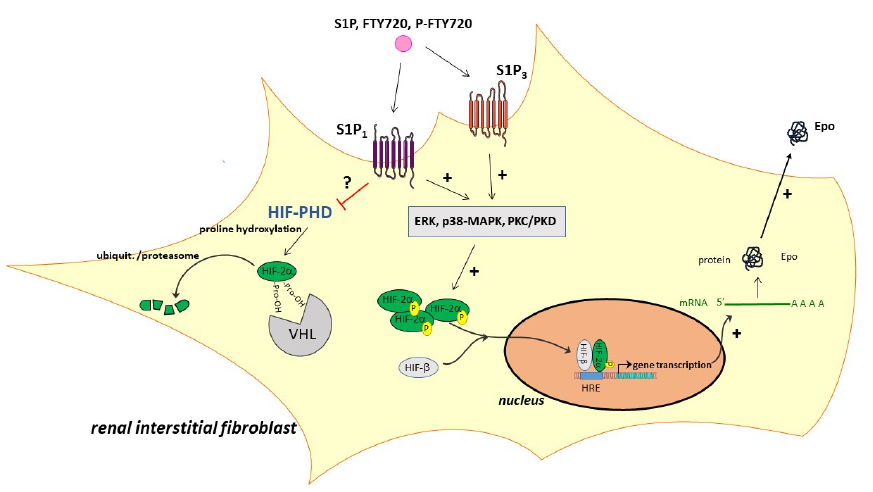
Figure 6. Schematic summary of the signal transduction pathways involved from S1P to Epo synthesis in interstitial fibroblasts. Epo, erythropoietin; ERK, extracellular signal-regulated protein kinases; PKC, protein kinase C; PKD, protein kinase D; HIF, hypoxia-inducible factor; HIF-PHD, HIF prolyl hydroxylase; HRE, hypoxia response element; VHL, von Hippel–Lindau